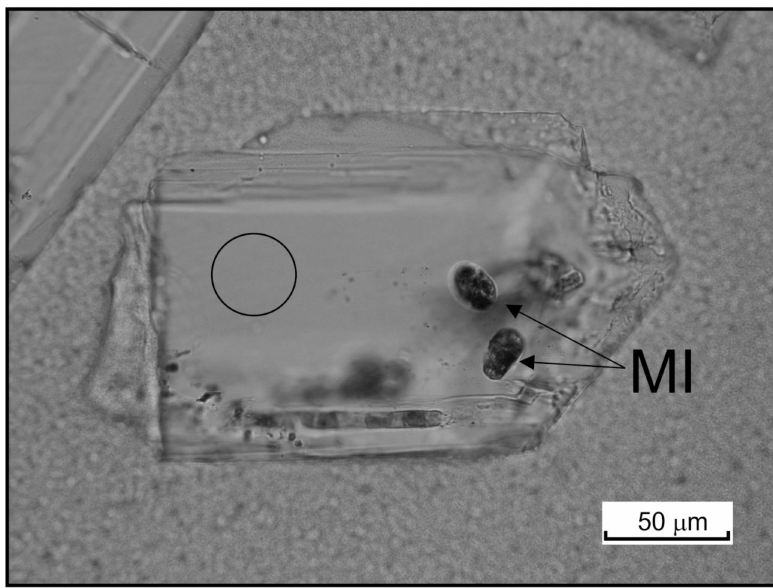
Figure 2. A typical apatite grain used for the U-Pb dating. MI—melt inclusions. The circle shows the size of the laser ablation spot.